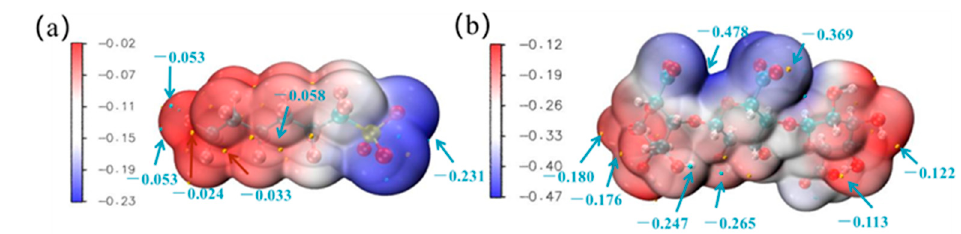
Figure 5. The van der Waals surface electrostatic potential of ( a ) PFHxS and ( b ) SA.